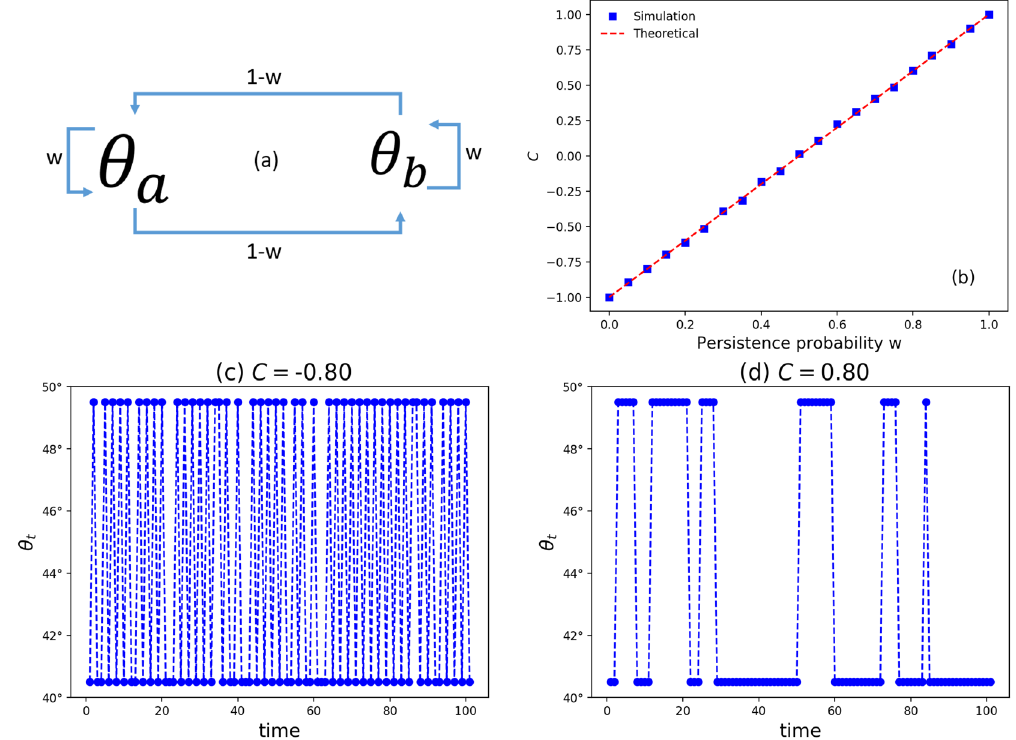
Figure 1. ( a ) Markov chain employed for tailoring the disorder with prescribed persistence probability w that T θ t provides the control of the autocorrelation with Eq. (29). ( b ) Autocorrelation of the sequence t 0 . Monte { } 5000 . The theoretical line comes from Eq. (29). ( c , d ) Time series for = Carlo simulations performed until t max = r )π/ 4 and θ b r )π/ 4 for r 0.1 and C 0.8 that θ t engineered from Markov chains with θ a ( 1 ( 1 = = ± = + = − 0.1, 0.9 comes from w = { }